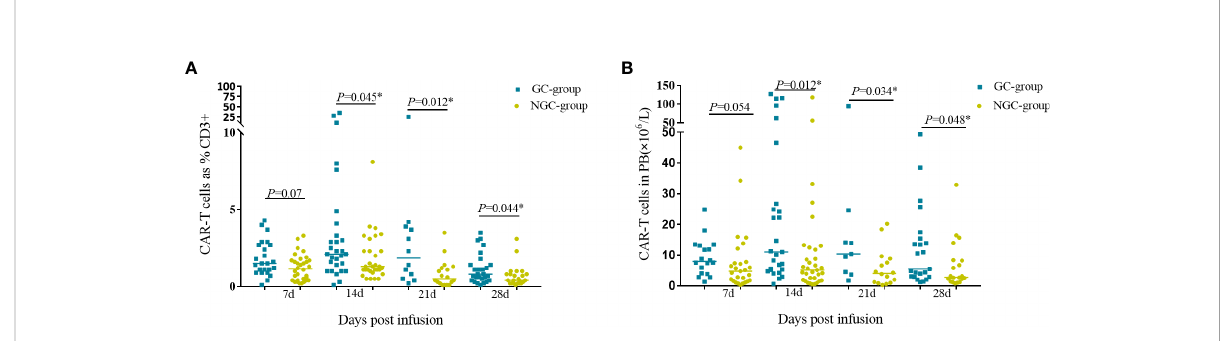
FIGURE 4 CAR-T cell expansion and persistence in peripheral blood. Proliferation of CAR-T cells in peripheral blood was assessed by fl ow cytometry on days 7, 14, 21, and 28. (A) . The percentage of CAR-T cells in the peripheral blood. (B) Counts of CAR-T cells in the peripheral blood. *Represents for statistically different (P <